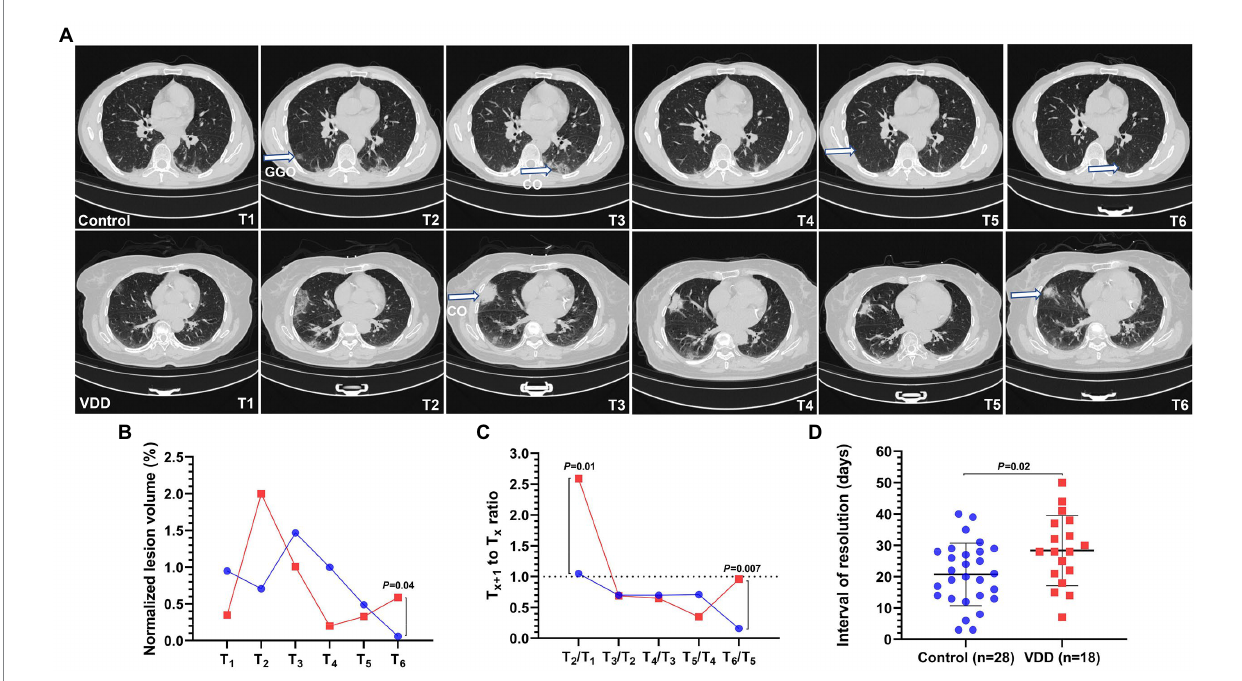
FIGURE 1 Lesion dynamics in six time periods from T 1 to T 6 after the onset of COVID-19 pneumonia induced by the Delta variant. T 1 to T 6 represent the following: T 1 ≤ 3; 3 < T 2 ≤ 7; 7 < T 3 ≤ 14; 14 < T 4 ≤ 21; 21 < T 5 ≤ 28; T 6 > 28 days. Pneumonia lesions on computed tomography (CT) were identified and measured by artificial intelligence (AI) and radiologists. The blue or red connecting line and symbols represent the control or VDD group, n = 7–28 or n = 9–18 per condition, respectively. Symbols in the line chart represent median. Scatter dot plot and error bars represent mean and standard deviation. GGO, ground-glass opacity; VDD, vitamin D deficiency; Control, without VDD. (A) COVID-19 pneumonia lesions mainly included GGO and consolidation (CO). (B) The normalized lesion volume between the control and VDD cases was significantly different (0.6 vs. 0.06%) within more than 28 days. (C) The T x + 1 to T x ratio of normalized lesion volume greater than or less than 1 indicates progression or improvement, respectively. Lesions in the VDD group progressed more rapidly (2.6 vs. 1.1) within 3 to 7 days and improved more slowly (0.96 vs. 0.16) after 28 days than those in the control group. (D) The interval of pneumonia resolution in the VDD group was longer (28 vs. 21 days) than that in the control